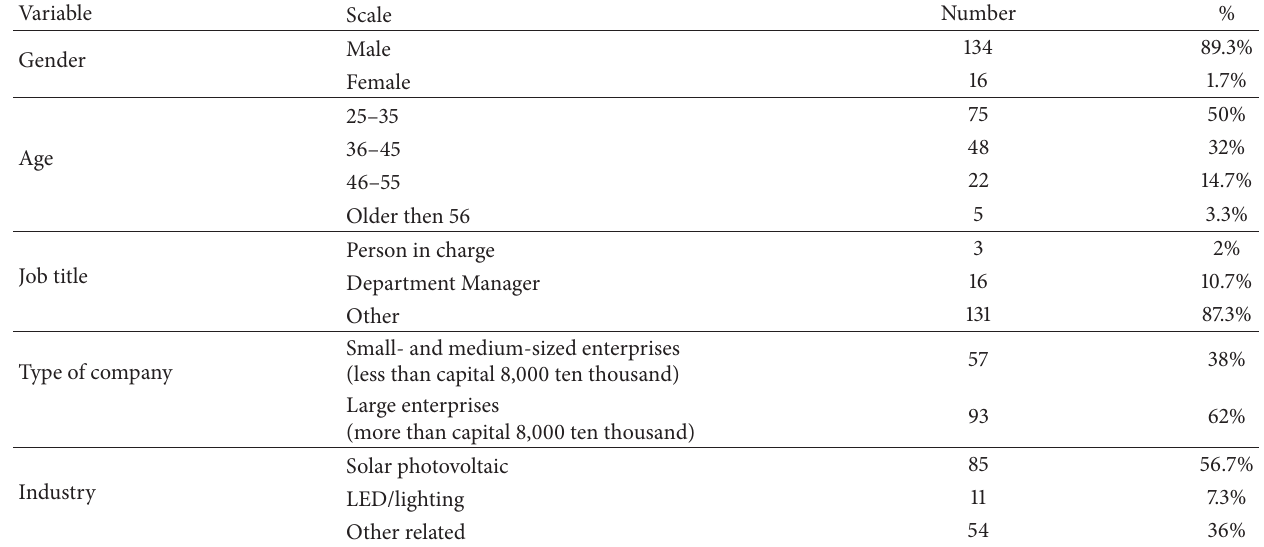
Table 3: Demographic data from industries respondents.